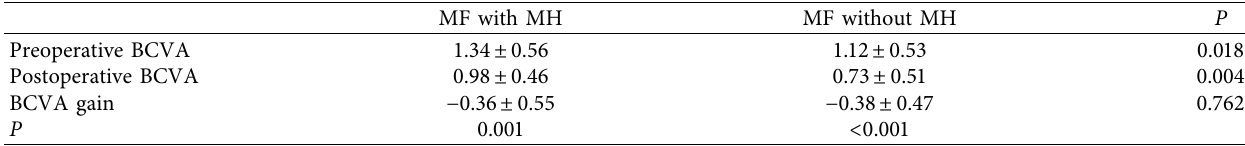
Table 2: Comparison of BCVA in eyes with or without MH.